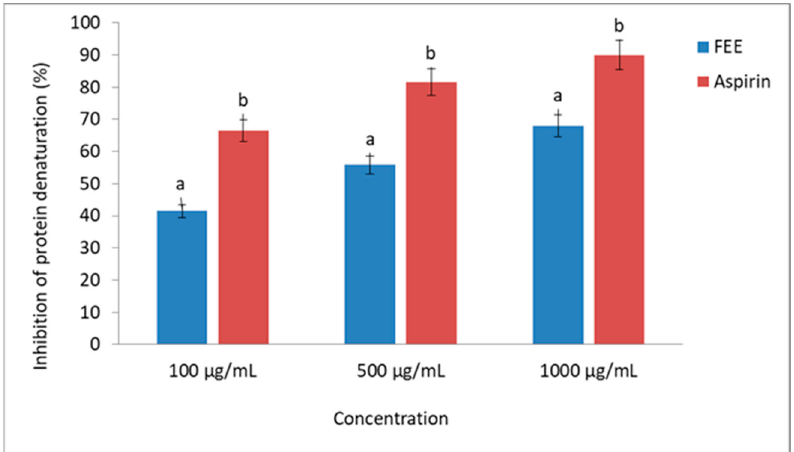
Figure 7. Effect of ethanolic extracts from E. angustifolium (FEE) on the inhibition of protein (BSA) denaturation. Acetylsalicylic acid (aspirin) was used as a control inhibitor. Data are the mean ± SD of three independent experiments, each consisting of three replicates per treatment group. Vertical lines represent the standard deviation. Different letters—values are significantly different, α < 0.05.